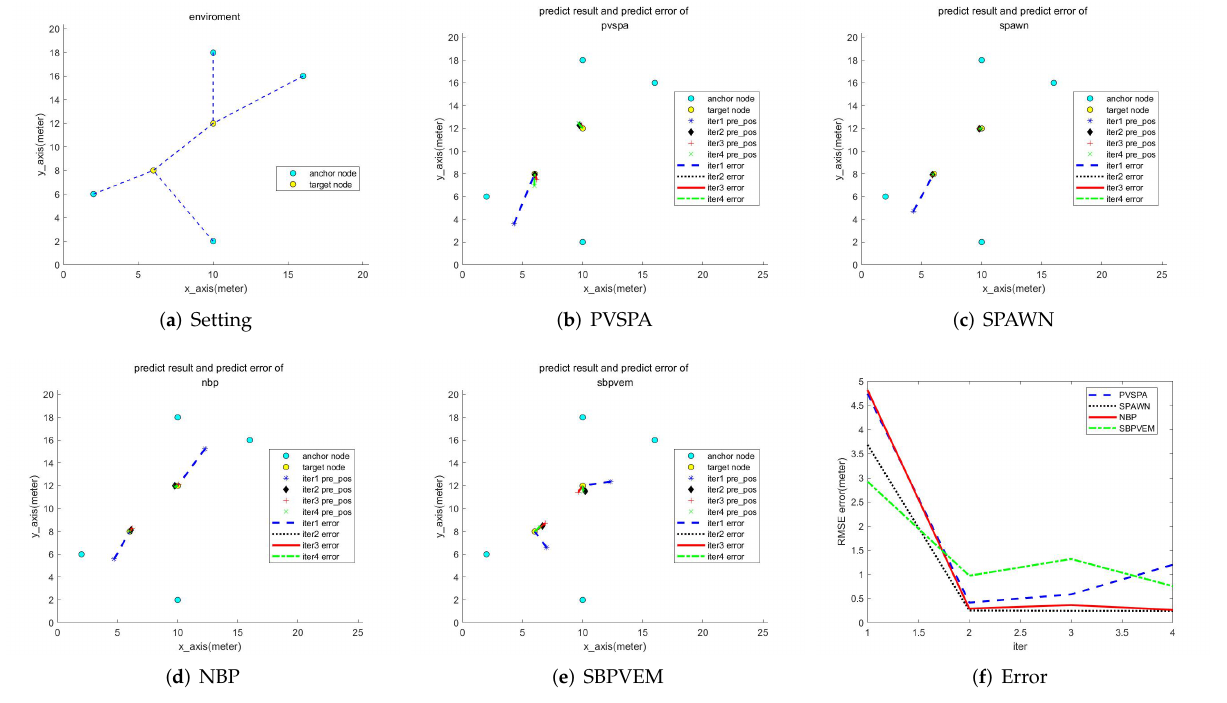
Figure 4. Location results of connection scenario 1. ( a ) exhibits the setting of scenario 1. Anchors are represented by cyan nodes, whereas yellow nodes represent targets. Blue dotted lines link two nodes with communication. PVSPA, SPAWN, NBP, and SBPVEM iterative positioning results and corresponding positioning errors are shown in ( b – e ). ( f ) comparing the prediction errors of various algorithms in the iterative